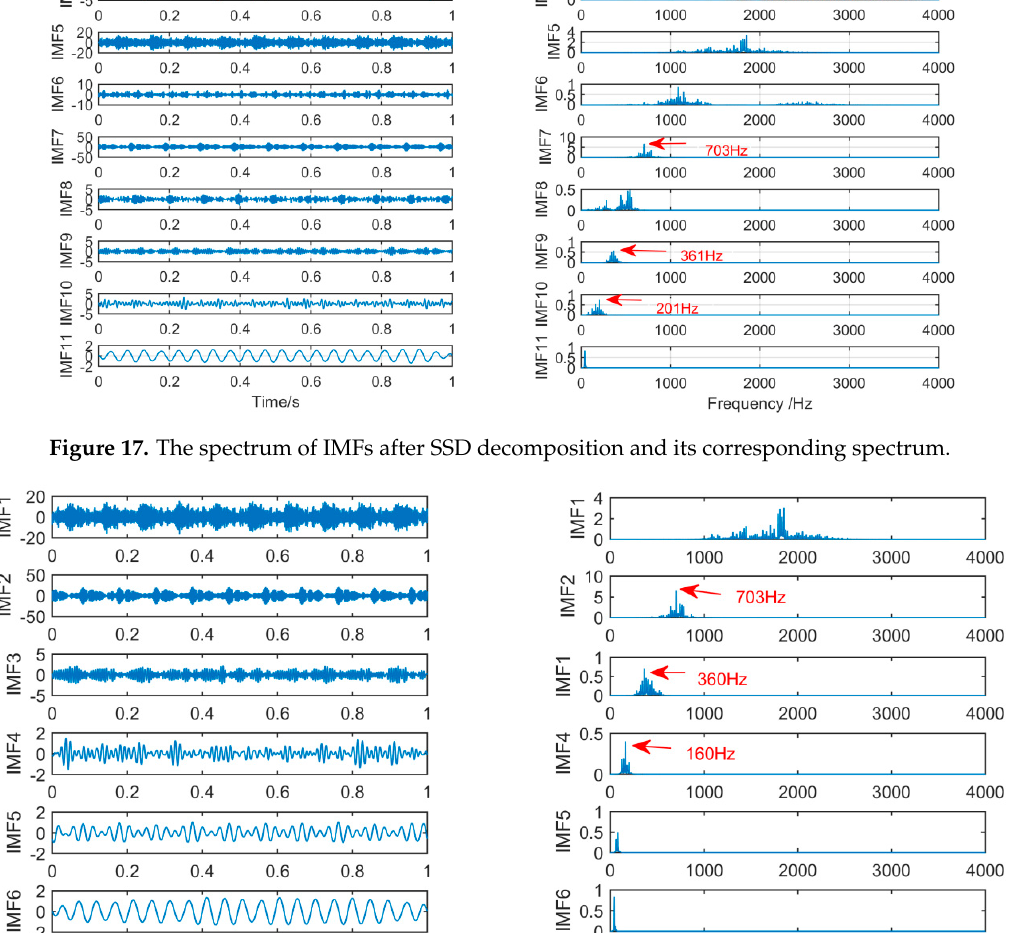
Figure 18. The spectrum of IMFs after MSSD decomposition and its corresponding spectrum.